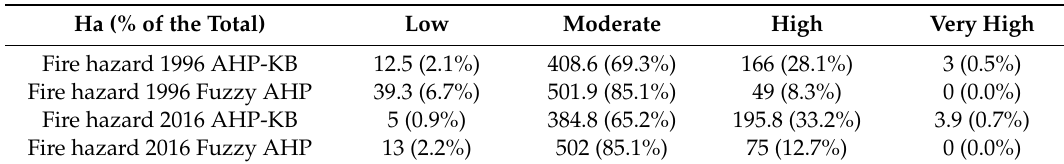
Table A3. Comparative assessment of fire hazard maps based on real fire history [Hectares (ha) − % of fire hazard for the entire island)].